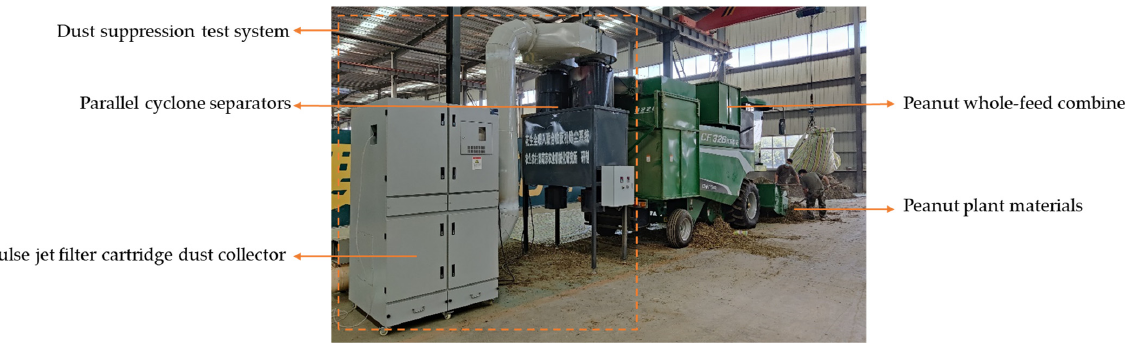
Figure 5. Experiment of the dust suppression test system.